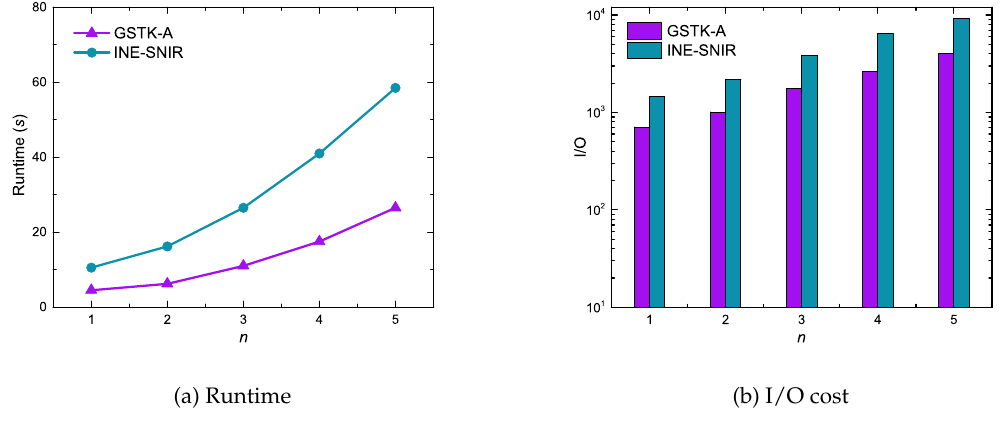
Figure 8. Effect of the number of keywords on runtime and I/O